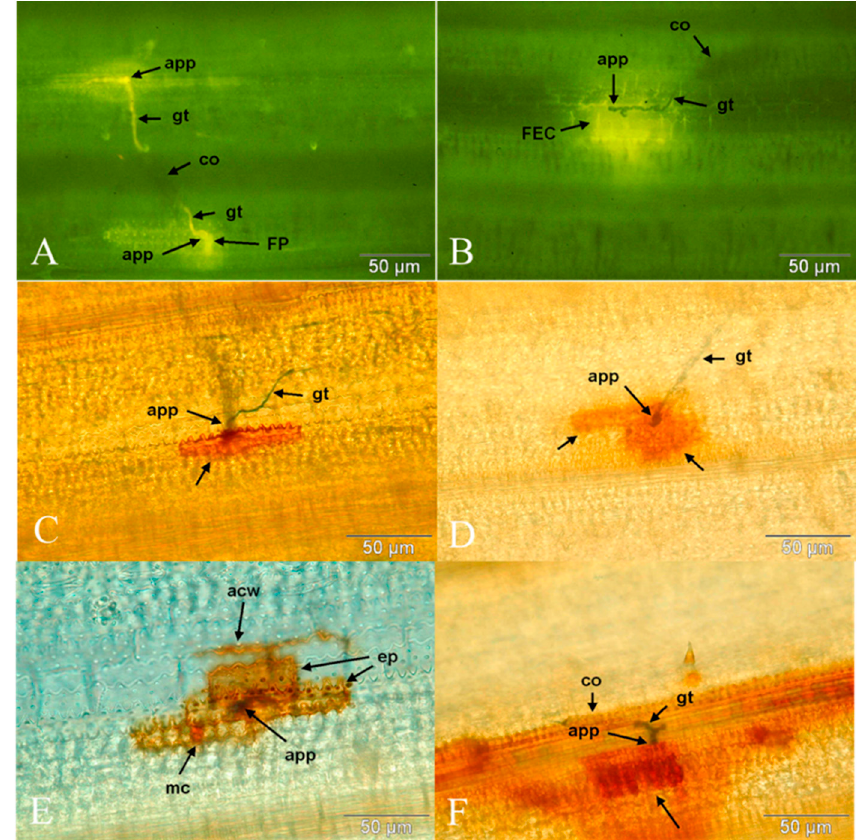
Figure 1. Details of infection biology and defence responses of rice cv. MTL189 infected by Bipolaris oryzae isolate K2 (less compatible interaction). ( A ) Autofluorescent papillae (FP) at penetration attempts of B. oryzae at 12 hai. ( B ) Multiple fluorescent epidermal cells (FEC) at 12 hai. ( C – F ) DAB staining showing hydrogen peroxide accumulation in relation to B. oryzae . ( C ) FEC at 12 hai. ( D ) FEC 16 hai. ( E ) Multiple FEC at 20 hai. ( F ) Multiple FEC and spreading staining reaction at 24 hai. acw: anticlinal epidermal cell wall; app: appressorium; co: conidium, ep: epidermal cell; FEC: fluorescent epidermal cell; FP: fluorescent papilla; gt: germ tube; mc: mesophyll cell. Arrows indicate DAB-stained regions.